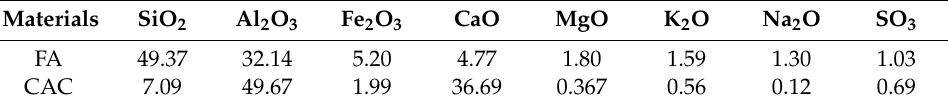
Table 1. Chemical composition of materials.